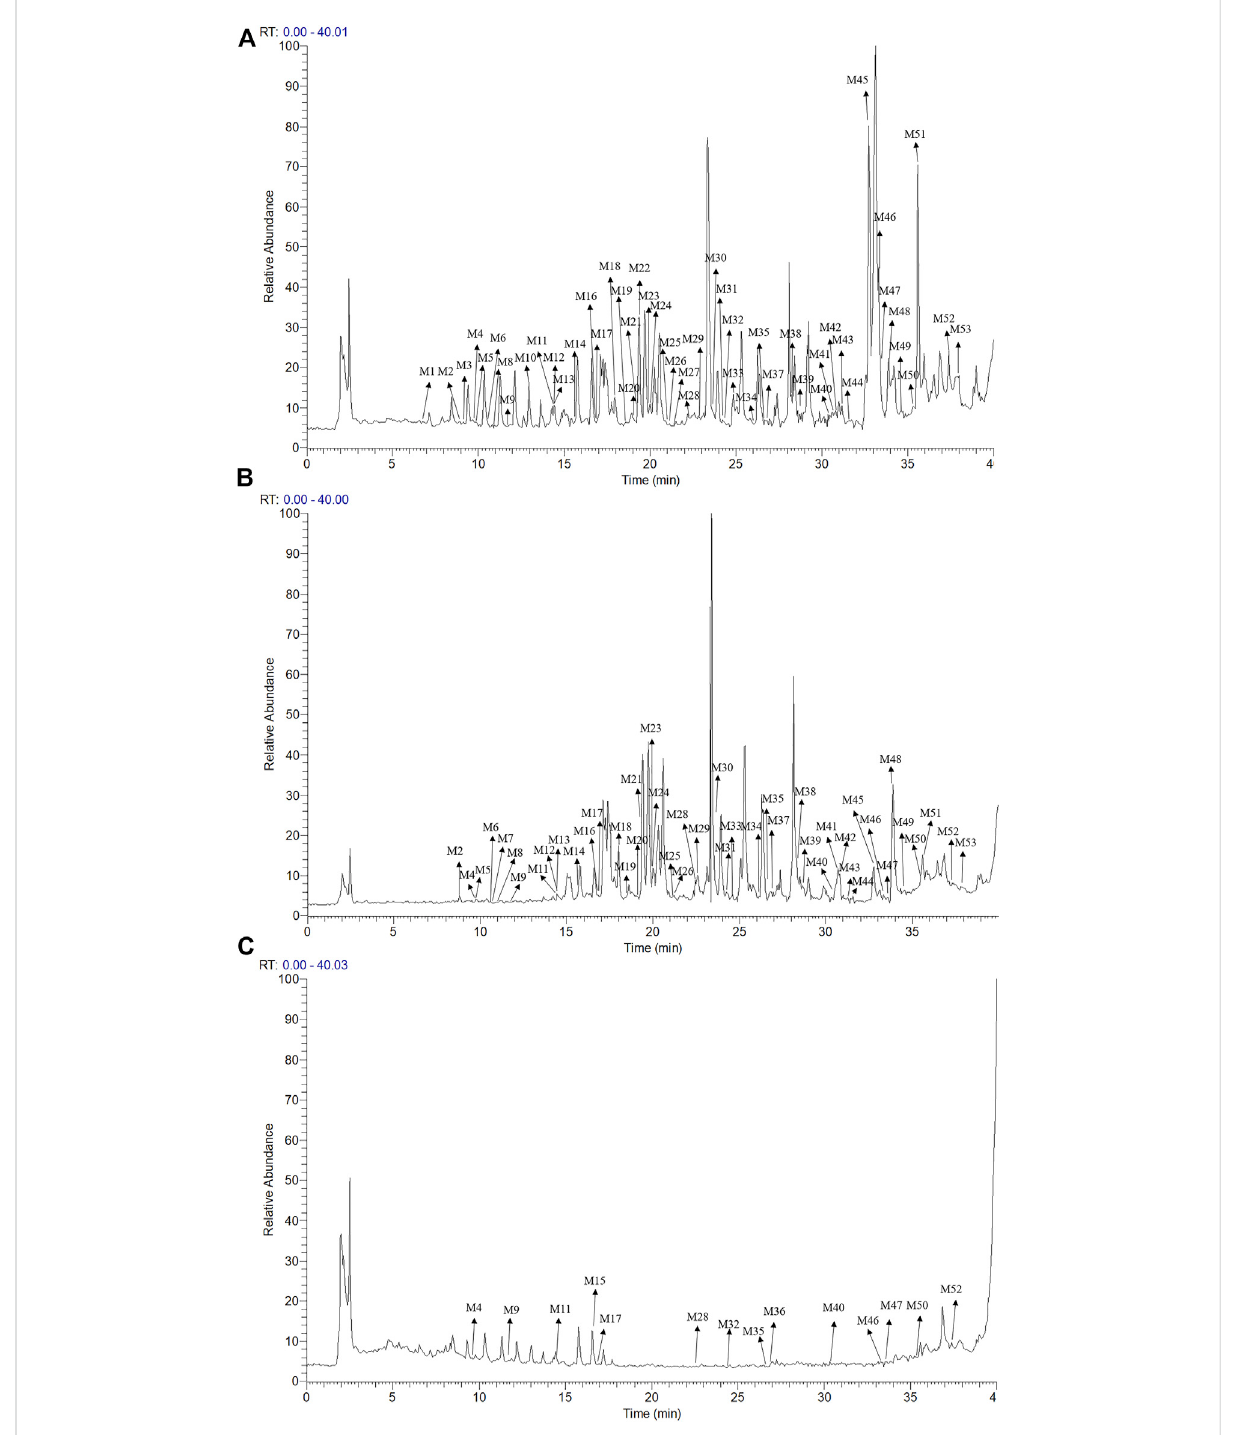
FIGURE 5 TIC chromatograms in the negative mode; (A) CR-SR extract, (B) CR extract, and (C) SR